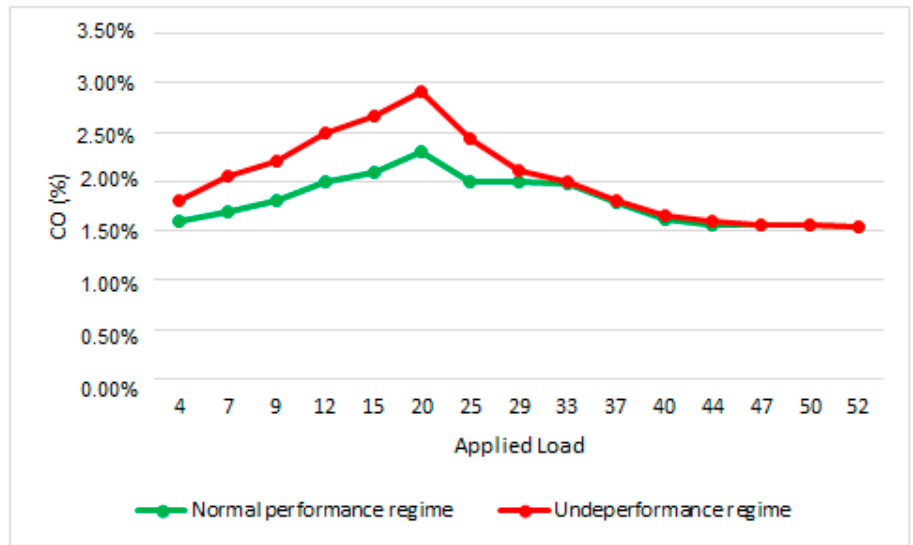
Figure 10. Variation of the CO content in the exhaust gas according to the applied loads.